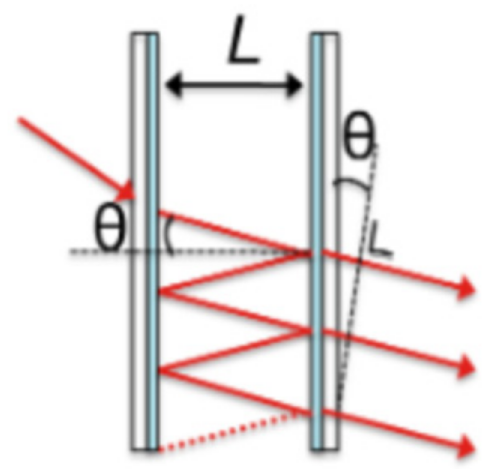
Figure 5. The Fabry–P é rot structures used to construct the hyperspectral sensor. Snapshot Hyperspectral Sensors: We integrate the hyperspectral (HSI) sensor into two categories of camera systems: snapshot HSI cameras and the snapscan HSI cameras. The snapshot camera system is to be used for the in-home edition and is detailed in this section (Section 5.1.3). The snapscan HSI camera is to be used for the PRO edition and is detailed in Section